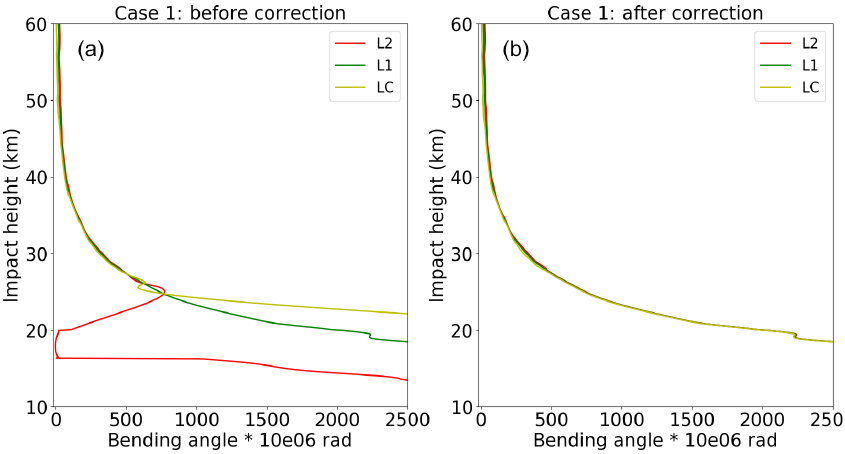
Figure 5. Case 1 – the bending angle of L2 (red), L1 (green) and LC (yellow) before (b) and after (a) correction.